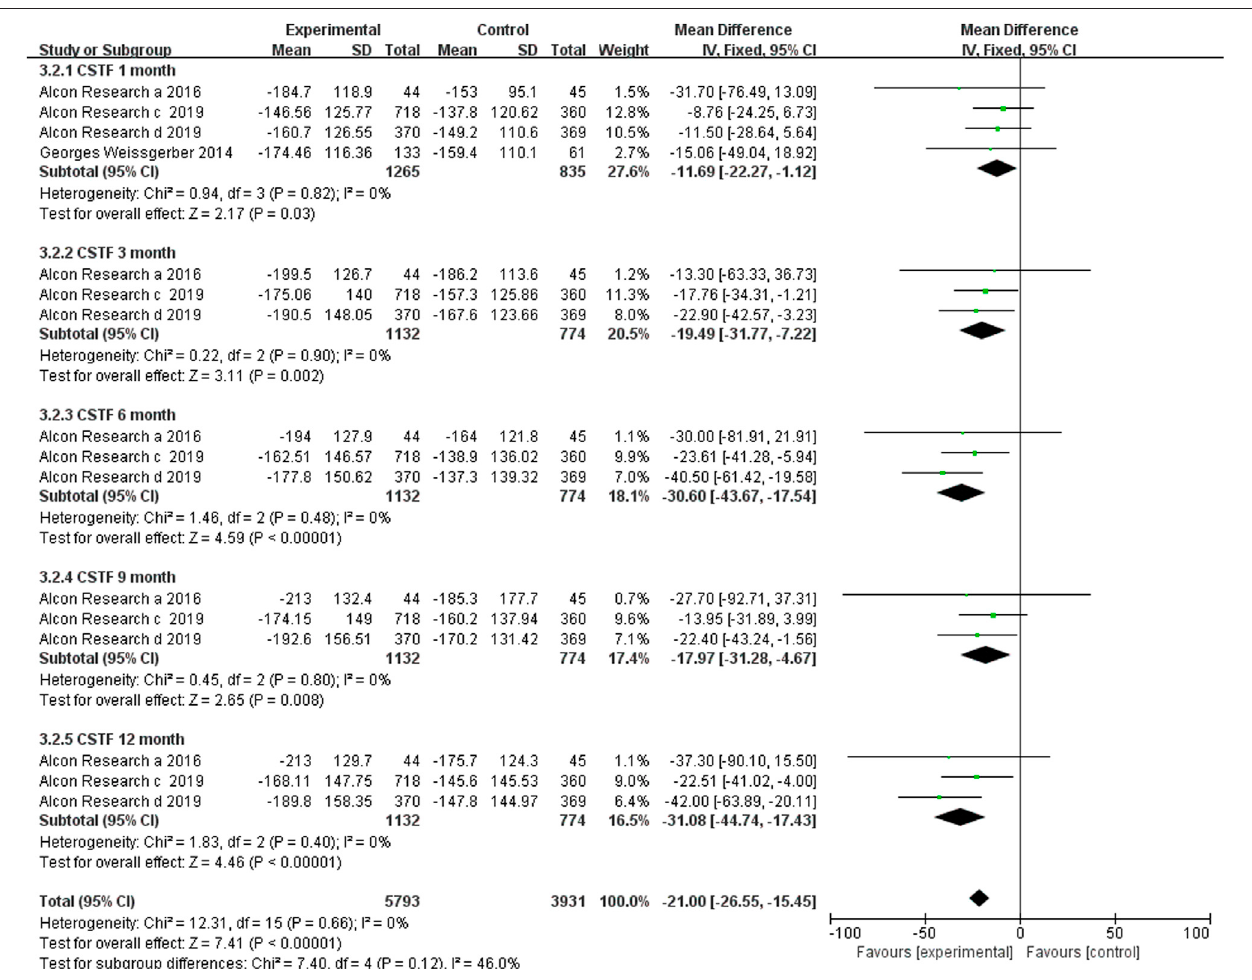
FIGURE 4 | Comparison of the effect on changes in CSFT between the brolucizumab-treated group and control group.